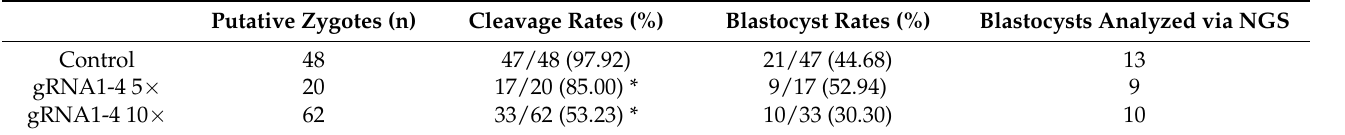
Table 2. Embryo development after zygote injection of CRISPR/Cas9 (combined gRNA 1 and 4)